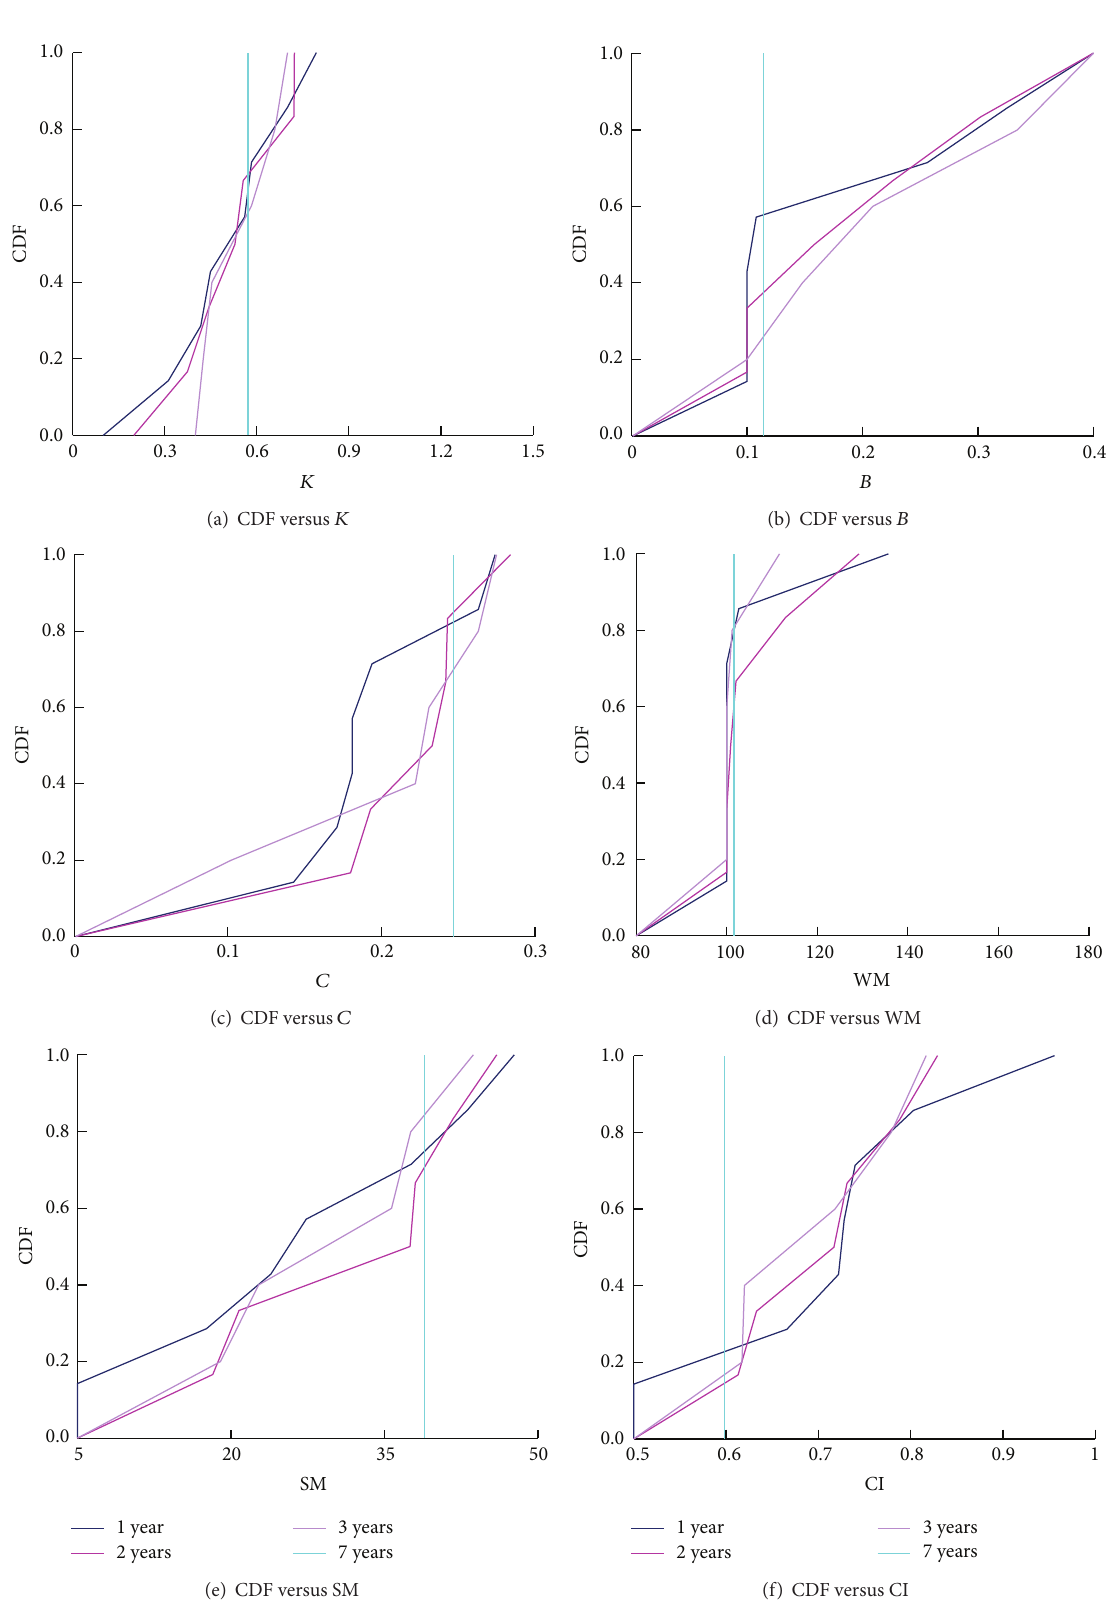
Figure 3: Cumulative distribution functions of the